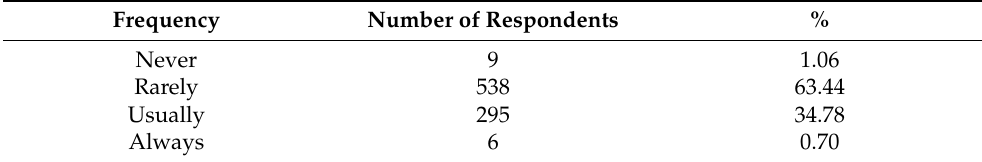
Table 2. Frequency of asking for more information.